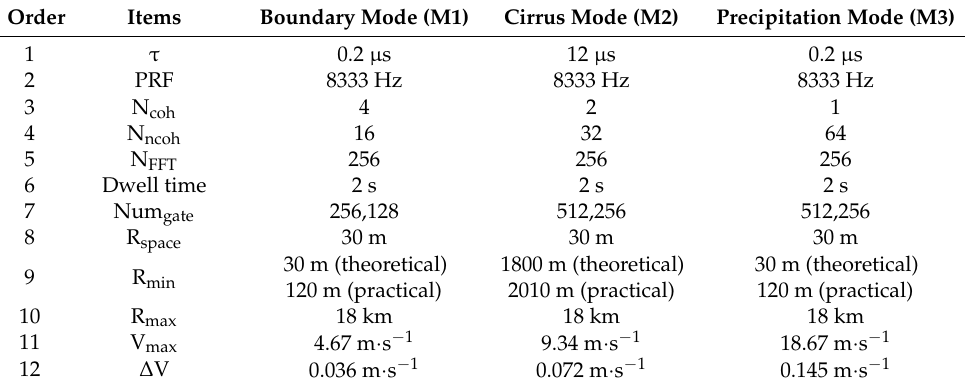
Table 2. Major operational parameters for the three operational